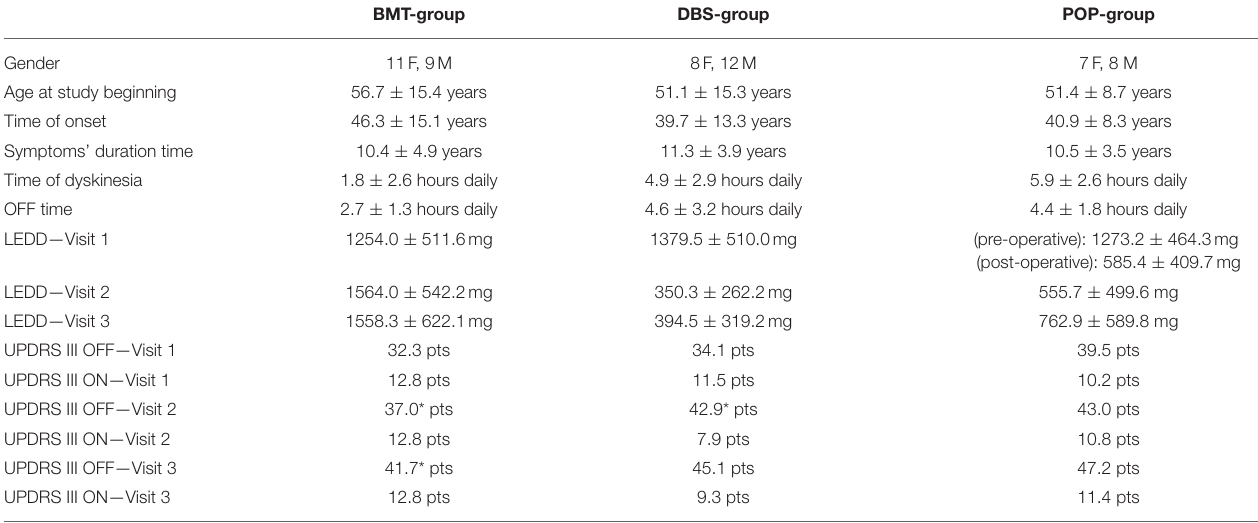
TABLE 1 | Study population. BMT-group DBS-group